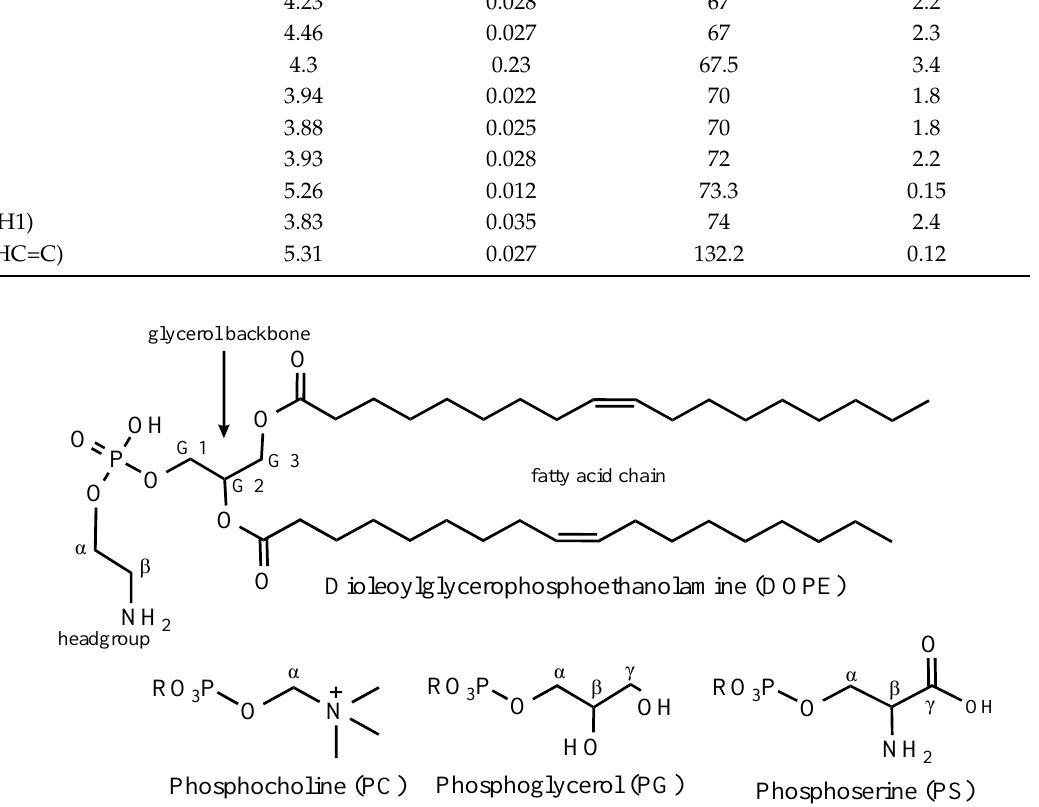
Figure 8. Structure of lipids of interest to this study and their nomenclature.